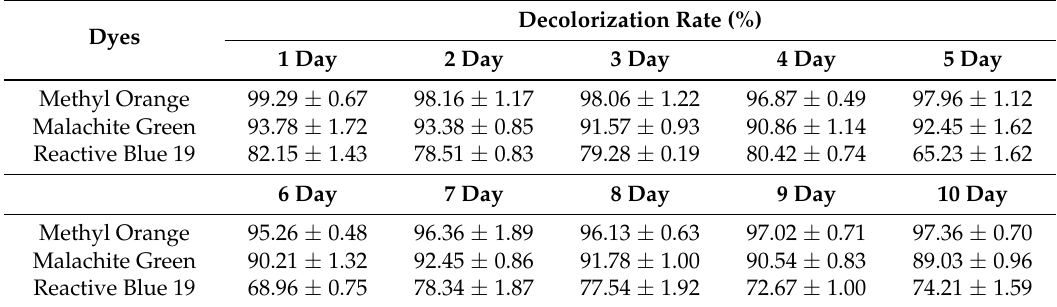
Table 2. Decolorization of three types of dye by the anaerobic sludge under continuous conditions. Decolorization Rate (%) Dyes